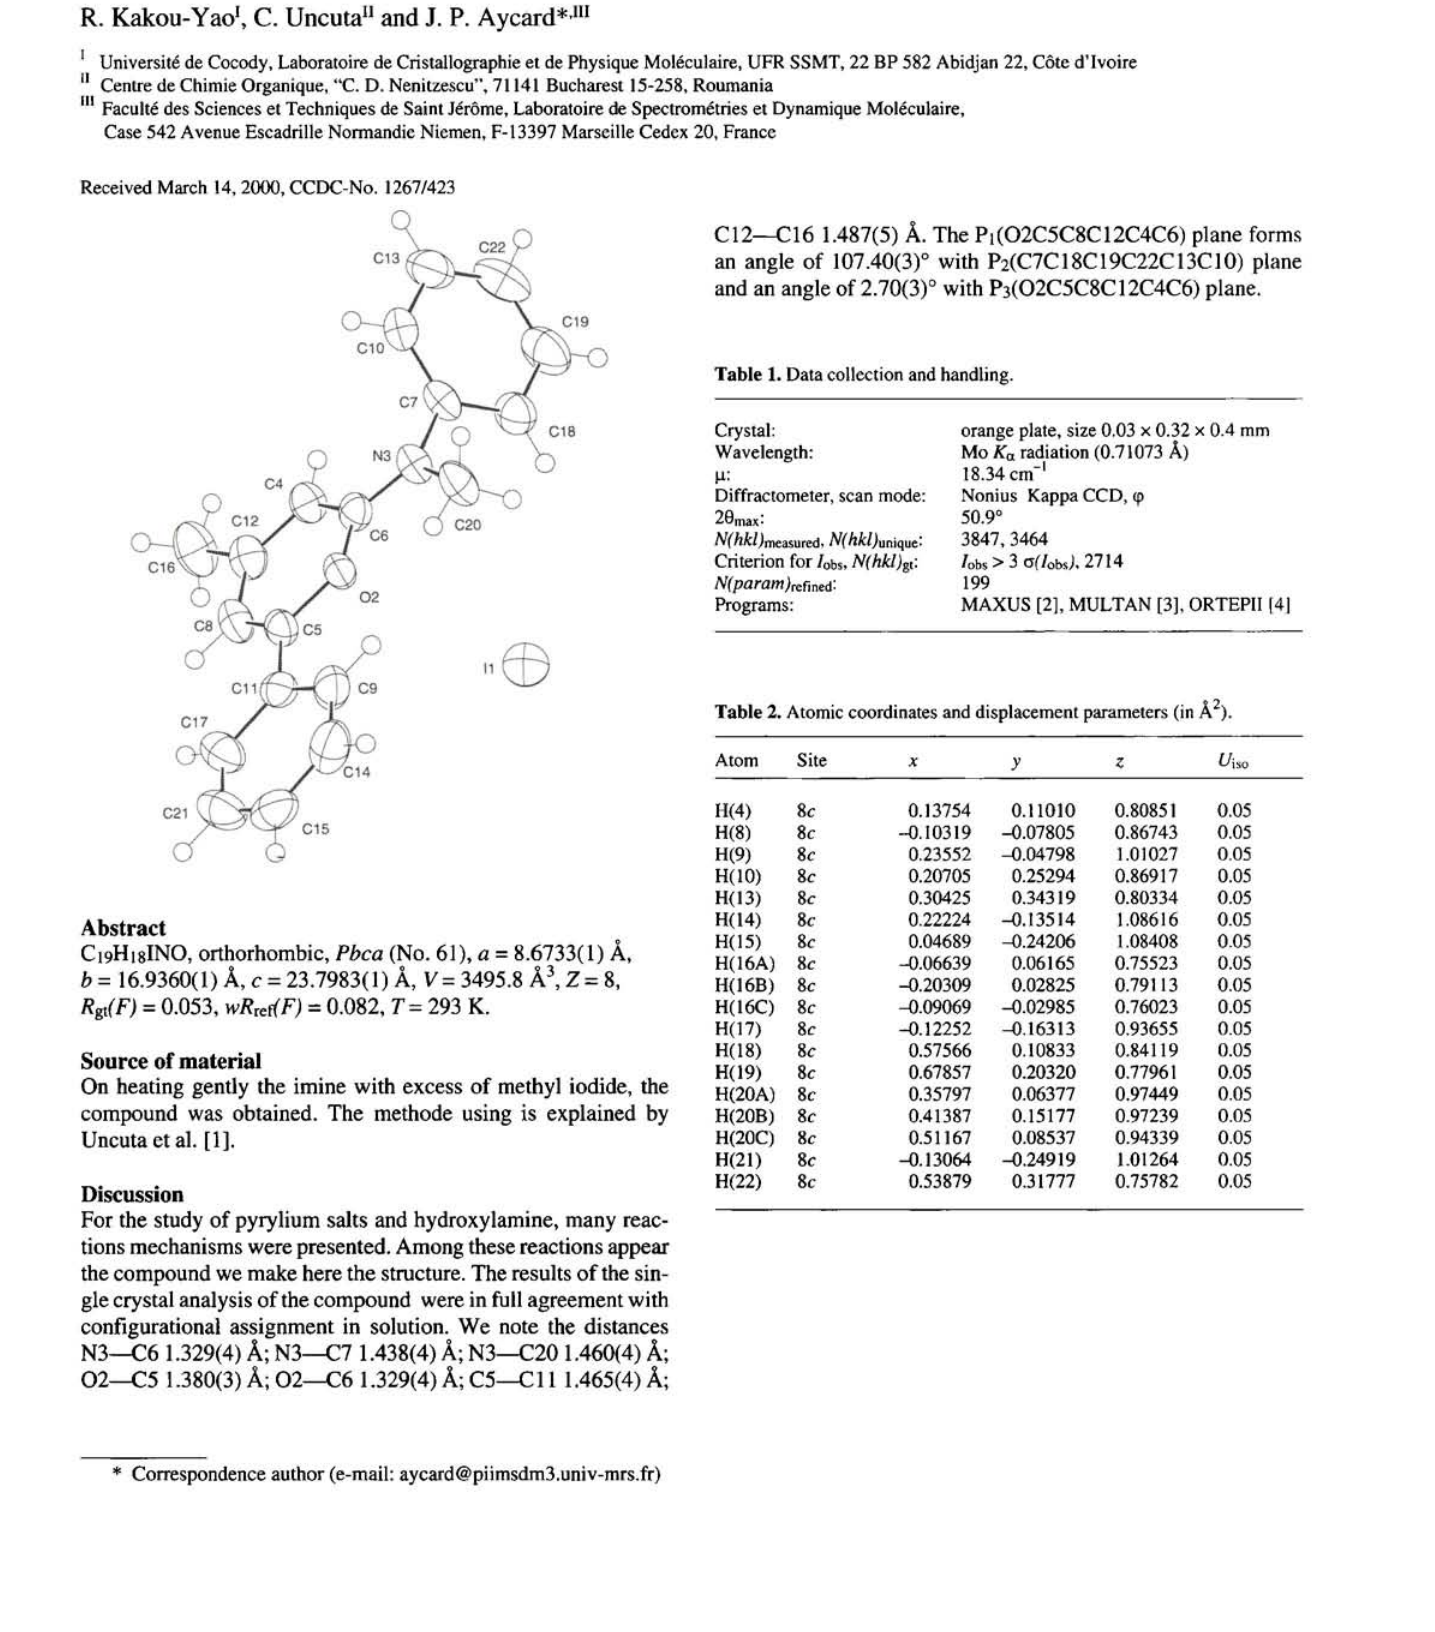
Table 2. Atomic coordinates and displacement parameters (in Â 2